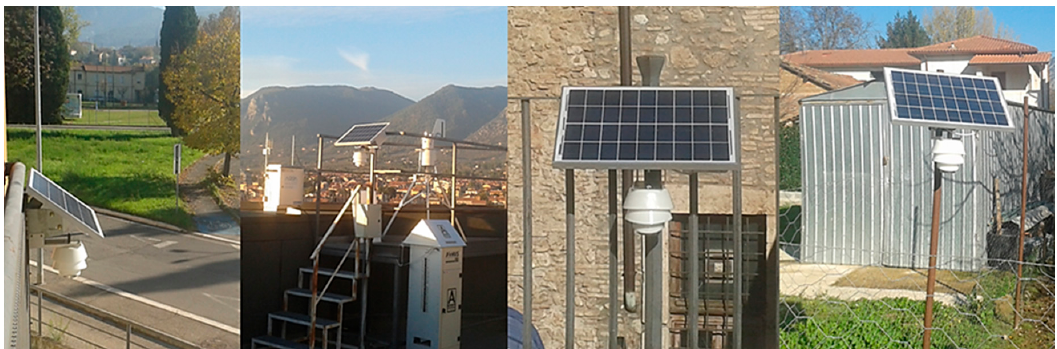
Figure 2. Smart samplers (SMART SAMPLER Fai Instruments, Fonte Nuova, Roma, Italy) installed in 4 of the 23 monitoring sites of Terni.